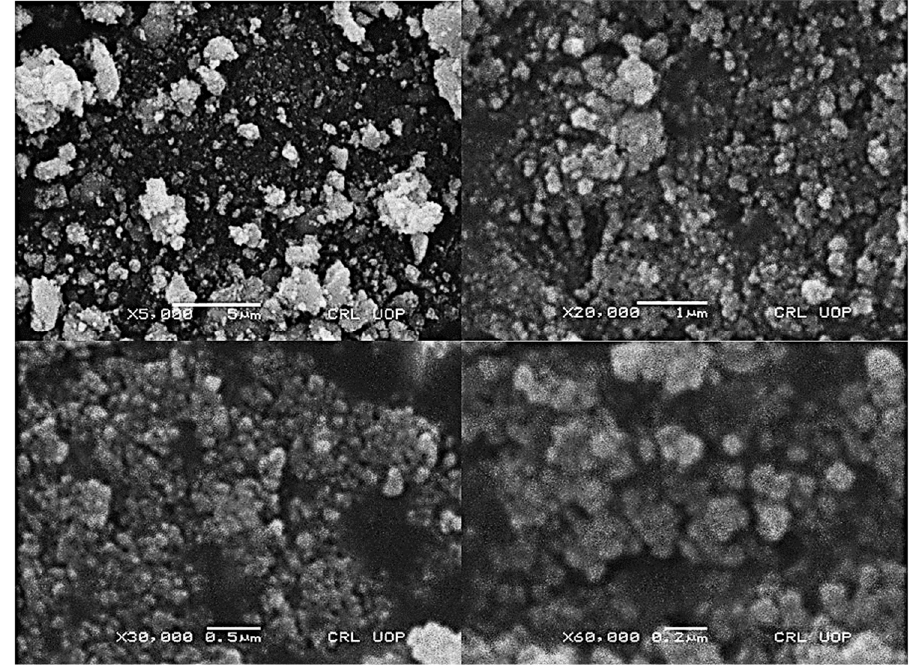
Figure 4. Scanningelectronmicroscopicanalysisofthe S.emodi